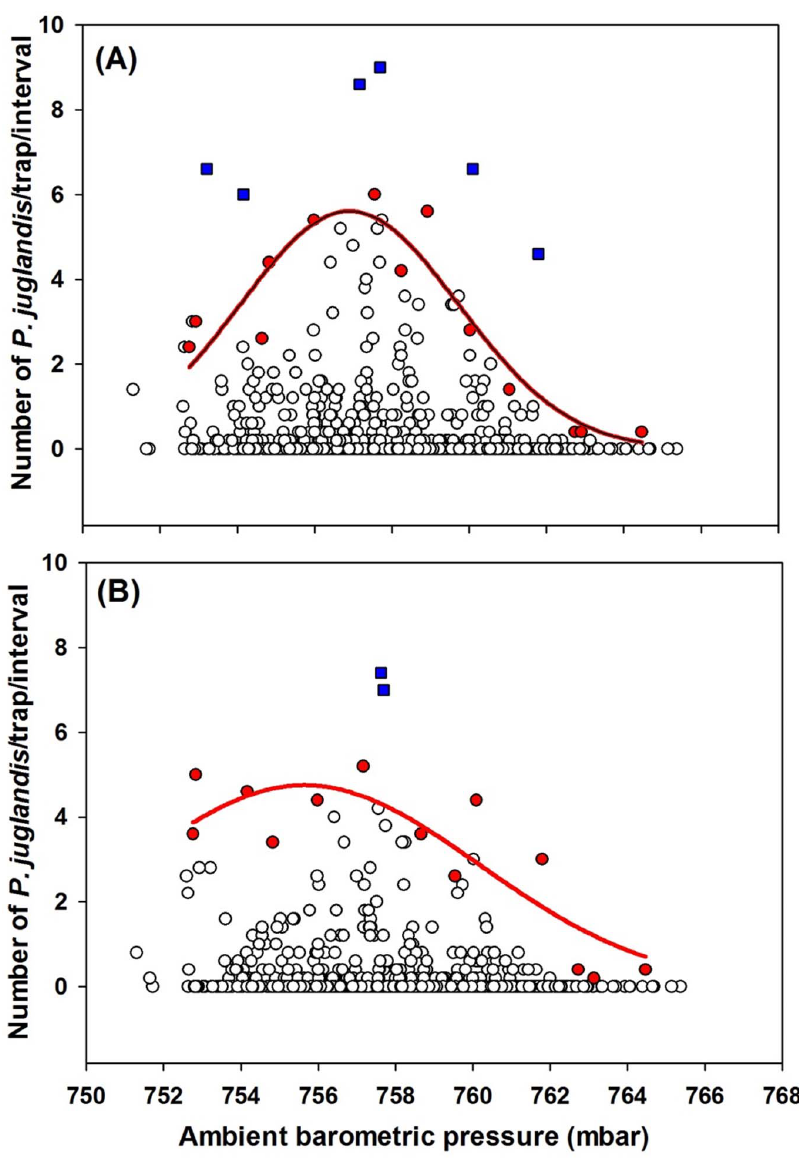
Figure 7. The Gaussian relationship ( Y = a 6 exp ( 2 ( X 2 X0 ) 2 /2 b )) between Pityophthorusjuglandis catches and ambient barometric pressure (mbar). (A) Female: N =873, F =33.70, P , 0.001, a =5.60, b =2.83, X 0 =756.90, adj. R 2 =0.84; (B) Male: N =856, F =14.73, P , 0.01, a =4.75, b =4.52, X 0 =755.65, adj. R 2 =0.70. Blue % : Outliers; Red q : Data points used to fit curves. These points were the greatest values of trap catches from each of the barometric pressure classes